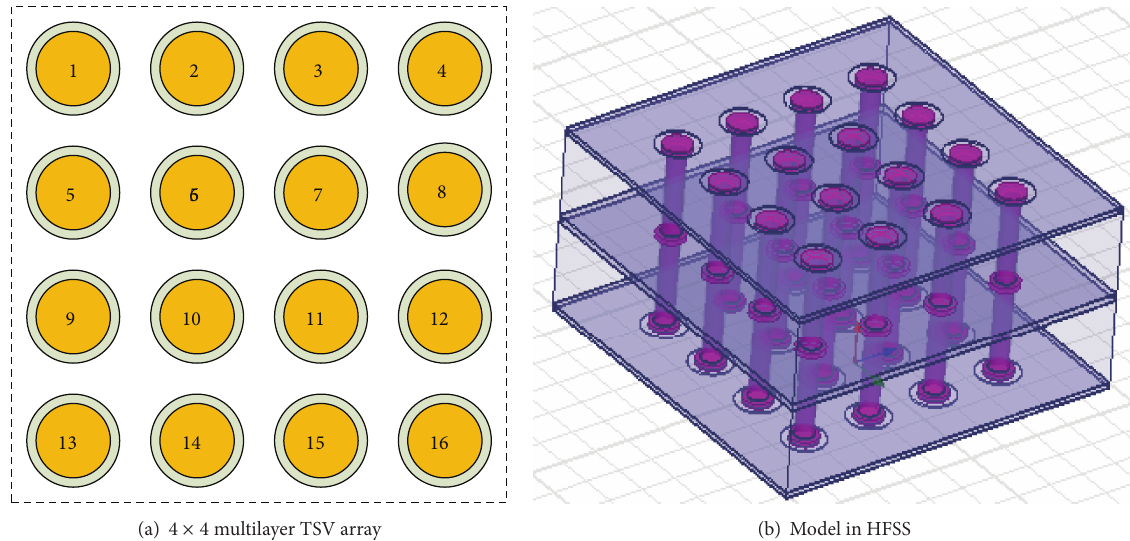
Figure 11: 4 × 4 multilayer TSV array, all TSVs are signal TSVs. There exist two copper layers on both sides serving as ground plane (parameters of the structure: thickness of the SnAg is 2 𝜇 m, 𝐻 = 3𝜇 m, 𝑅 = 8𝜇 m, ℎ TSV = 50 𝜇 m, 𝑟 TSV = 5 𝜇 m, 𝑡 = 1𝜇 m, 𝑡 OX = 0.6 𝜇 m, and = 40 𝜇 m). 𝑝 TSV